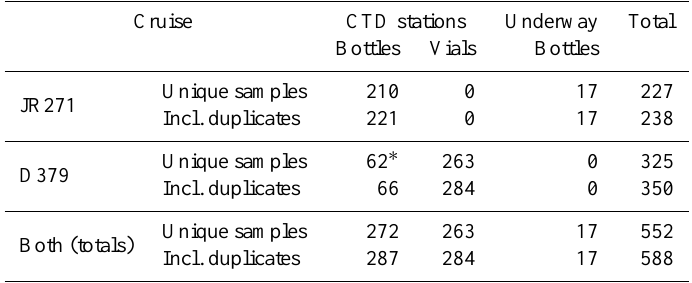
Table 1. Quantities and types of samples collected during cruises JR271 and D379, and types of sample containers used. D379 duplicates where one sample was collected in each type of container are counted in the “Unique samples – Bottles” cell (asterisked). The row labelled “Both (totals)” shows the total number of samples collected during both cruises. Cruise CTD stations Underway Total Bottles Vials Bottles Unique samples 210 0 17 227 JR271 Incl. duplicates Unique D379